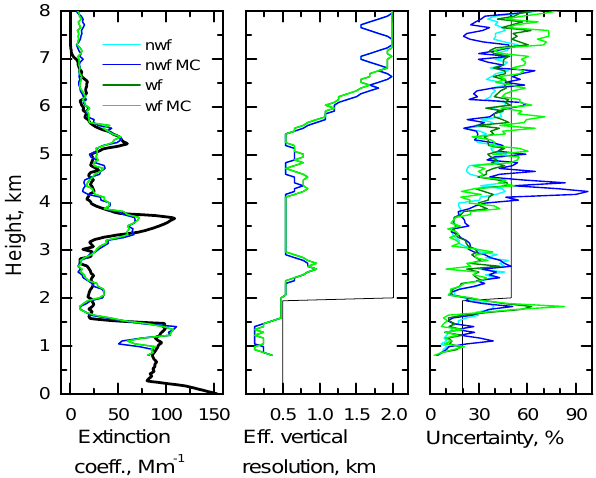
Figure 2. Same as Fig. 1, but for profiles of the particle extinction coefficient at 532nm. All ELDA profiles were obtained with auto- mated smoothing with maximum allowable relative errors of 20 and 50% below and above 2km,